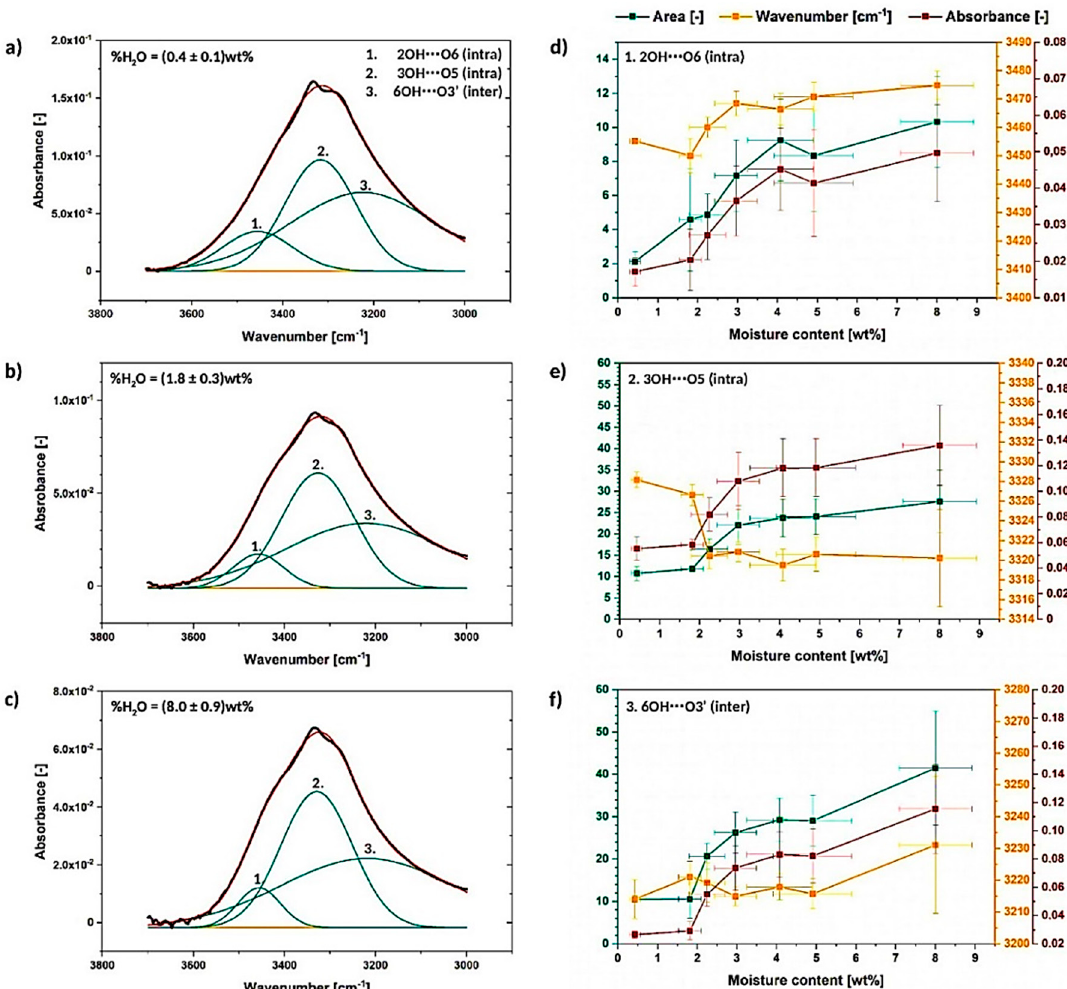
Figure 6. Deconvoluted absorption band between 3700–3000 cm − 1 for the cellulose moisture content of (0.4 ± 0.1) wt% ( a ), (1.8 ± 0.3) wt% ( b ) and (8.0 ± 0.9) wt% ( c ) with graphs illustrating the changes in the deconvoluted peak area, wavenumber and absorbance ( d – f ).